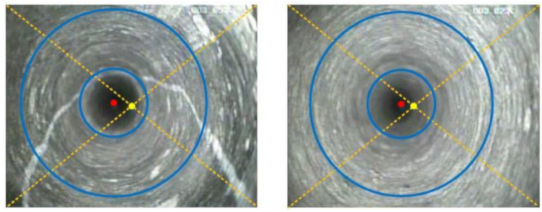
Figure 2. The drilled hole center deviation.